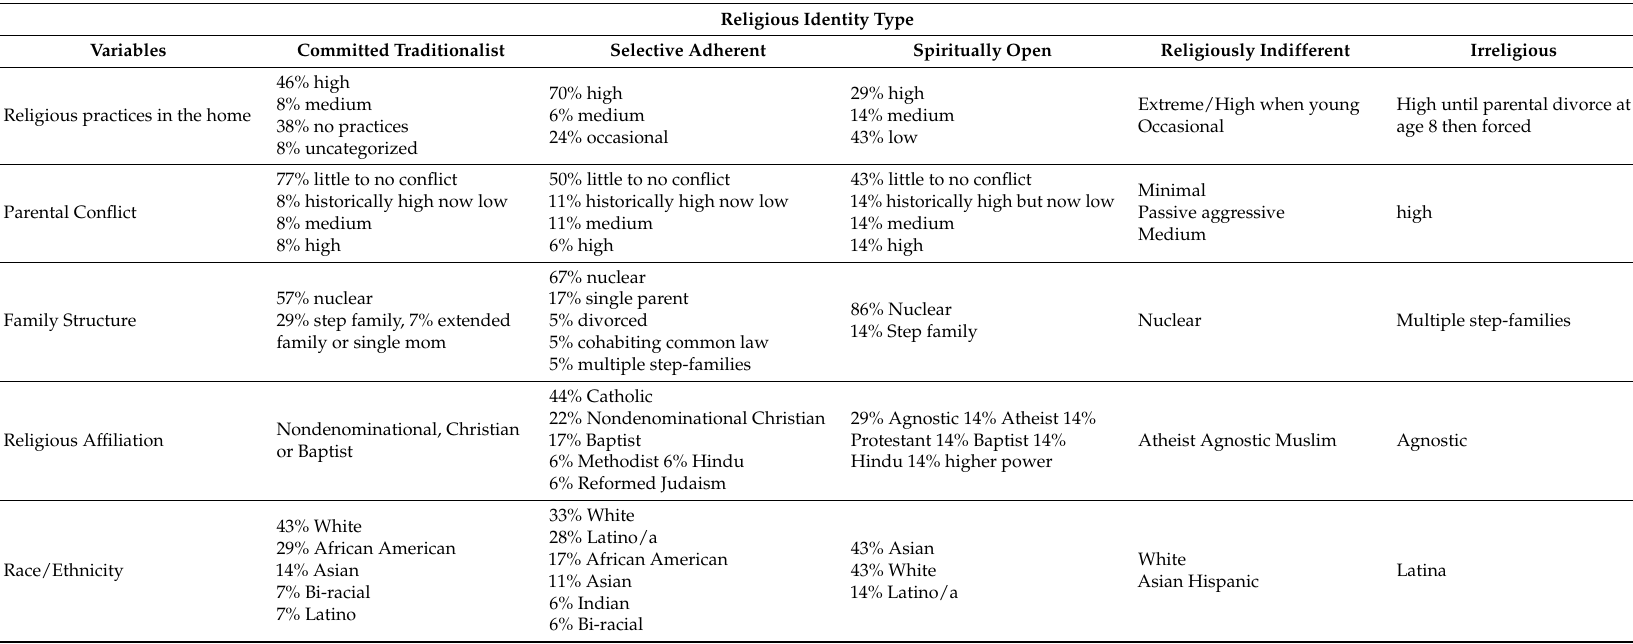
Table 2. Summary of Family Context, Process and Demographic Variables across Five Religious Identity